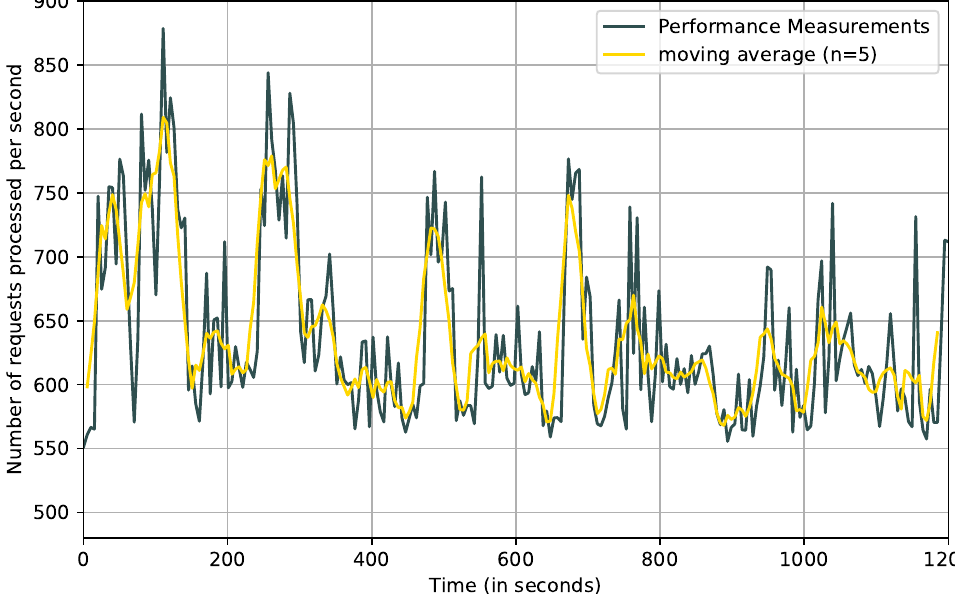
Figure 12. The results obtained by stress testing the system with in-memory queues over the course of 1200 s. Number of requests are measured and reset every 5 s. The plot shows the average number of requests processed per second over each 5 s interval. The moving average is computed with a window size n =